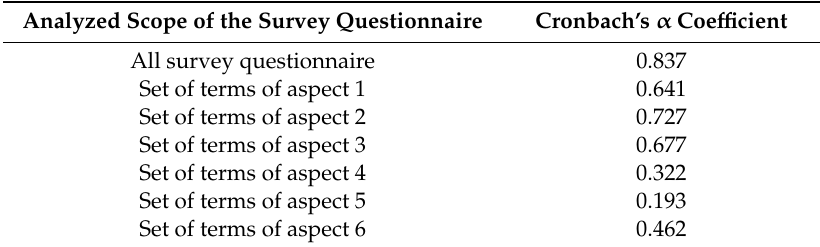
Table 3. Internal consistency of the survey questionnaire.